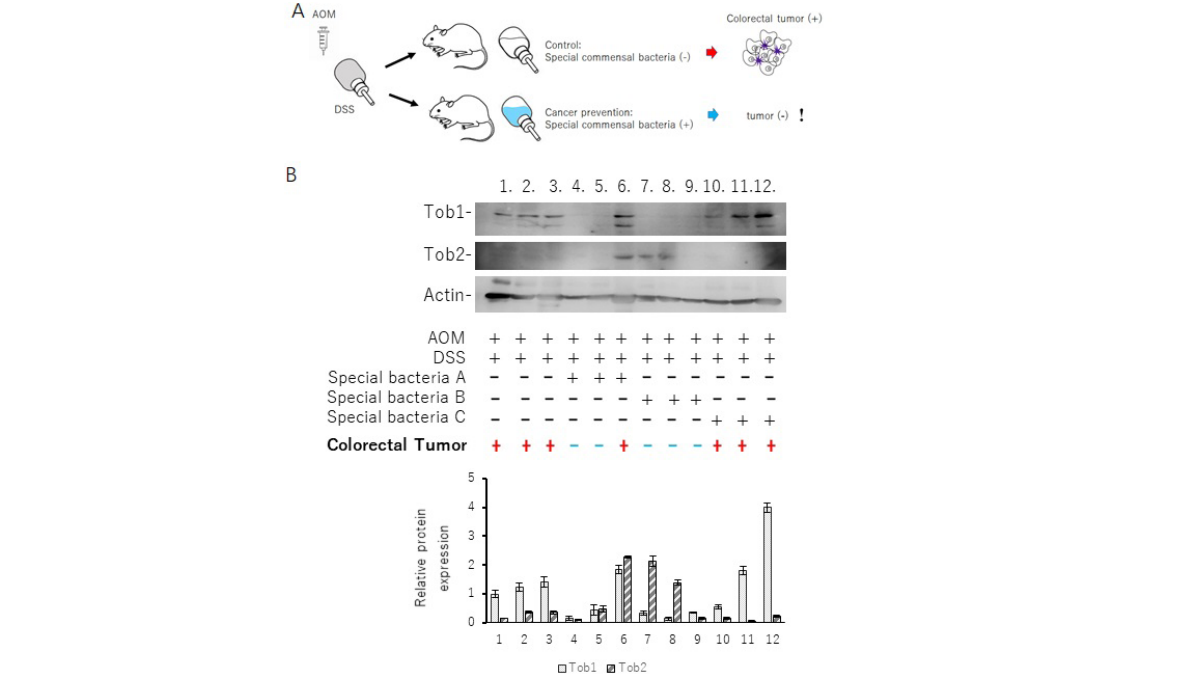
Figure 2 . ICR mice were treated with AOM/DSS to establish a mice model of IBD related colorectal tumorigenesis. Twelve treated mice were randomly divided into four groups with or without three types of special bacteria (A, B, and C) exposure in drinking. The mice were sacrificed after the end of the 14th week. Examination of the colon showed visible colorectal tumors at the mice of number 1, 2, 3, 6, 10, 11, 12. Tumors were mainly located in the distal portion of the colon. Protein isolation from the proximal portion of the colon and western blots were performed with the indicated antibodies as described elsewhere. Quantitation of Tob1 and Tob2 relative protein levels has been shown at lower panel. Data are means ± standard error of mean ( n = 3 in each group). !: indication of an amazing result; black +: used; black –: not used; red +: tumor existed; blue –: tumor not